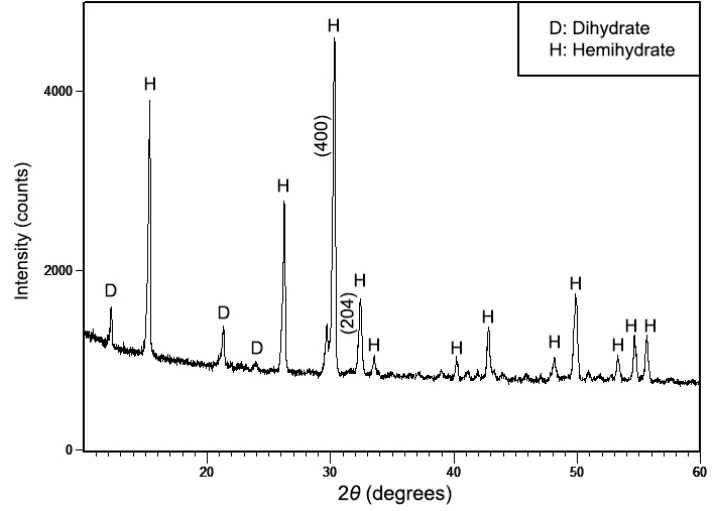
Figure 2. X-ray di ff raction (XRD) pattern of the synthesized Figure 2. X-ray diffraction (XRD) pattern of the synthesized powder.